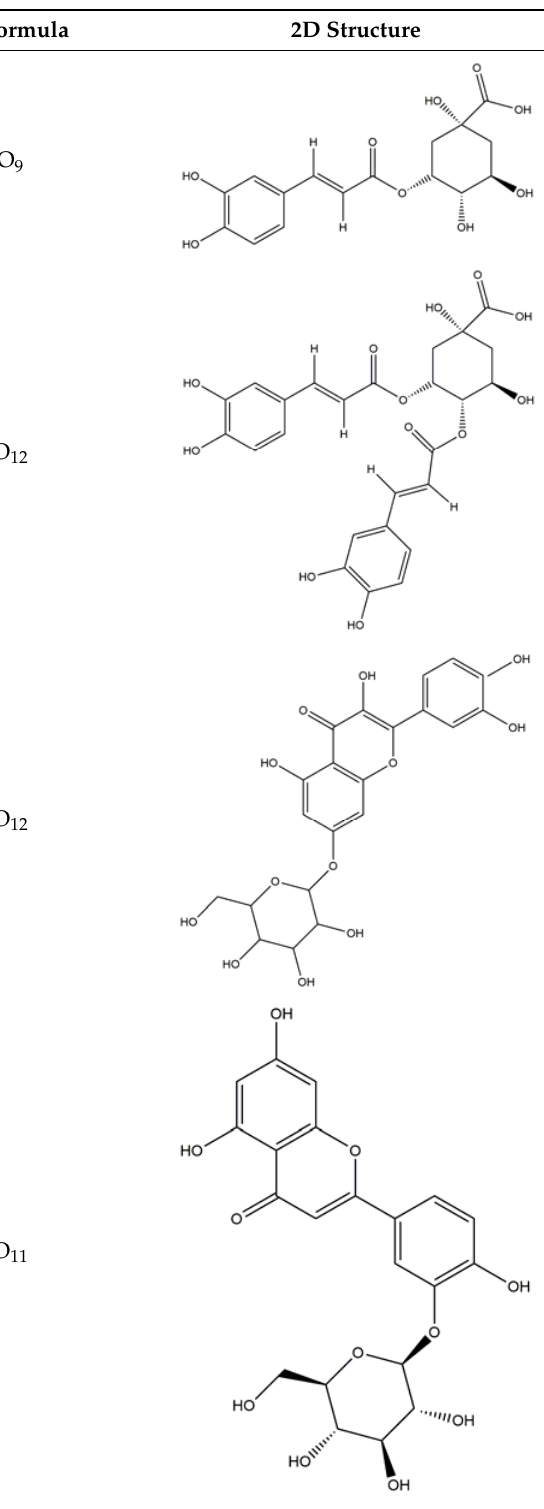
Table 1. Main active ingredients from LJF.